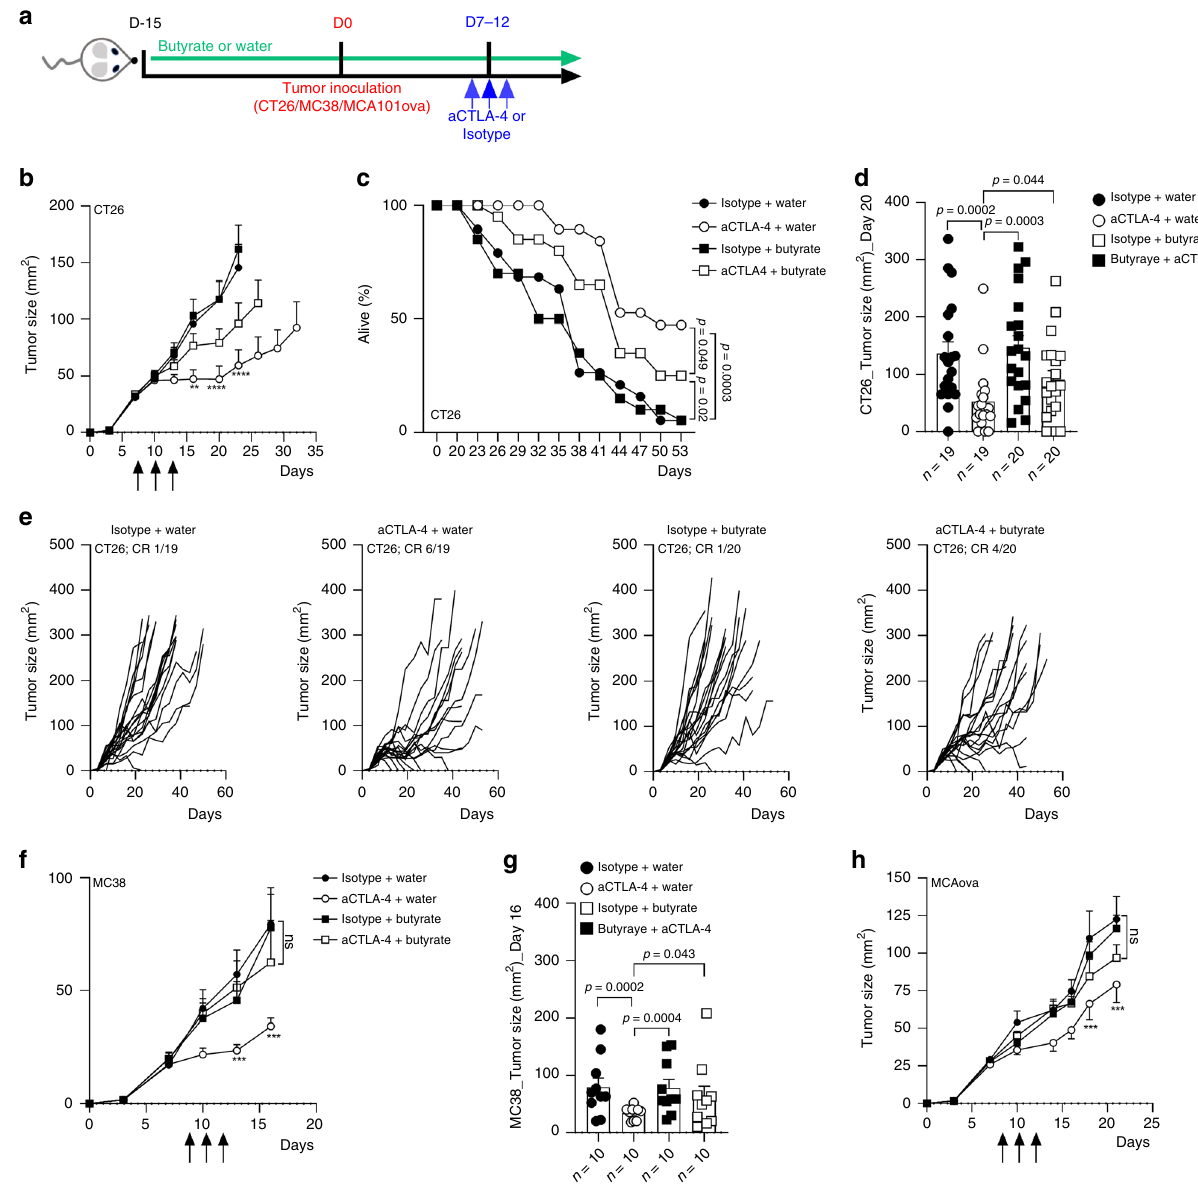
Fig. 3 Sodium butyrate diminished antitumor ef fi cacy of CTLA-4 blockade in mice. a Experimental setting. b Tumor growth of CT26 in Balb/c mice. White circles anti-CTLA-4 (aCTLA-4; clone 9D9) + water ( n = 19); Black circles isotype control (IgG2b; clone MPC-11) + water ( n = 19); white squares anti-CTLA-4 (aCTLA-4) + sodium butyrate in drinking water ( n = 20); black squares isotype control + sodium butyrate in drinking water ( n = 20); ** p = 0.0029 and **** p < 0.0001. c % of survival in each group at each day of the experiment. d As in ( b ), but median tumor size (mm 2 + / − SEM) at Day 20 in each group. e As in ( b ) but, CT26 tumor size over time after tumor inoculation in each group. Each line represents one mouse. Complete responses (CR) are indicated on each graph. f Tumor growth of MC38 in C57/Bl6 mice ( n = 10 per group); ** p = 0.0098 and *** p = .0002. g As in ( f ) but median tumor size (mm 2 + / − SEM) at Day 16 in each group. h Tumor growth of MCA101 OVA in C57/Bl6 mice ( n = 9 (Isotype + water and aCTLA-4 + water) or 10 (Butyrate + water and aCTLA-4 + butyrate) per group); *** p = 0.0001. Each dot represents one mouse; a pool of two independent experiments is shown ( b , c , d and e ); one representative experiment out of two experiments is shown ( f and h ). Two-way ANOVA was used ( b , f , g and h ); Log-rank (Mantel- Cox) test was used for comparison of two-to-two survival curves ( c ). Only aCTLA-4 + water and Isotype + water p -values are shown on the graphs ( b , f and h ). Mann Whitney (two-tailed) test was used ( d, g ). Exact p -values are indicated on each graph; ns, not signi fi